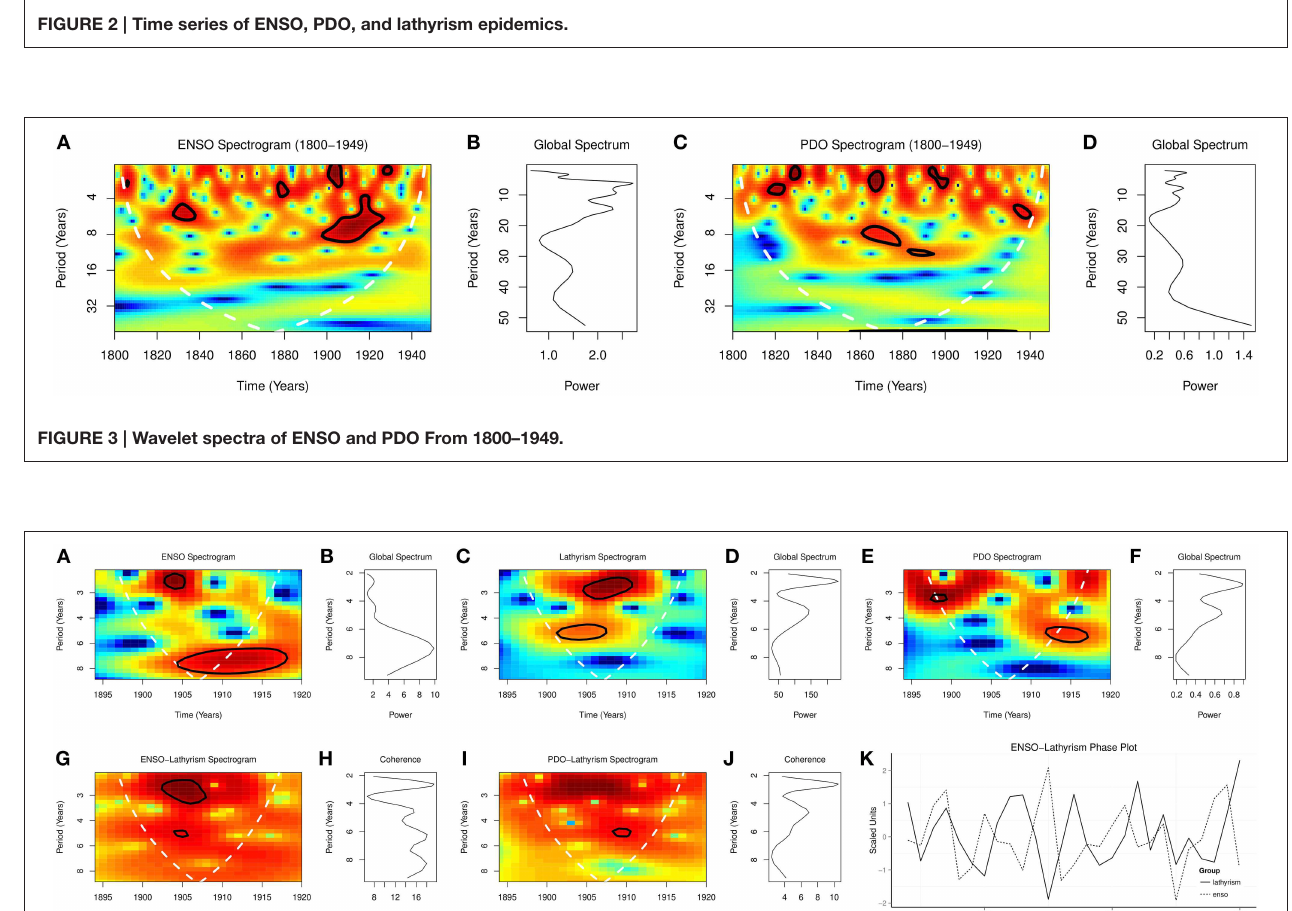
FIGURE 2 | Time series of ENSO, PDO, and lathyrism epidemics.